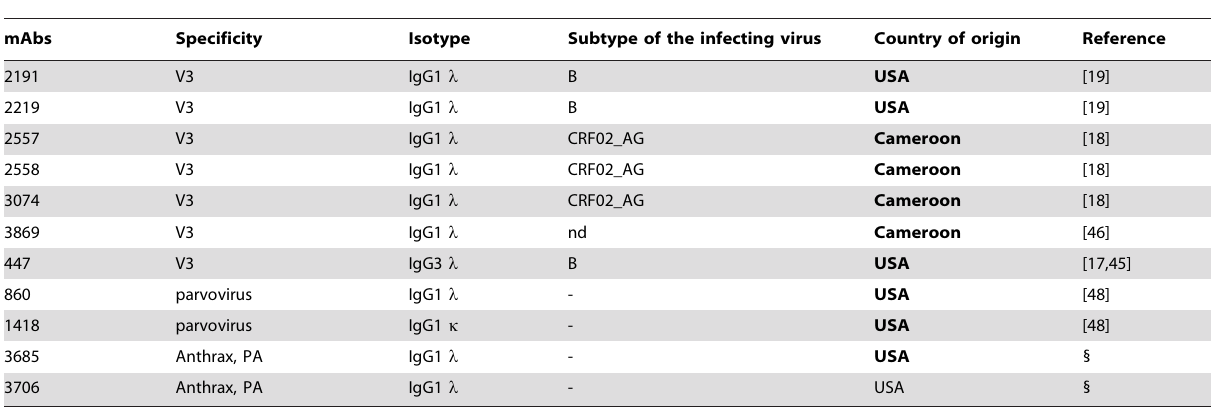
Table 1. Characteristics of human mAbs used for this